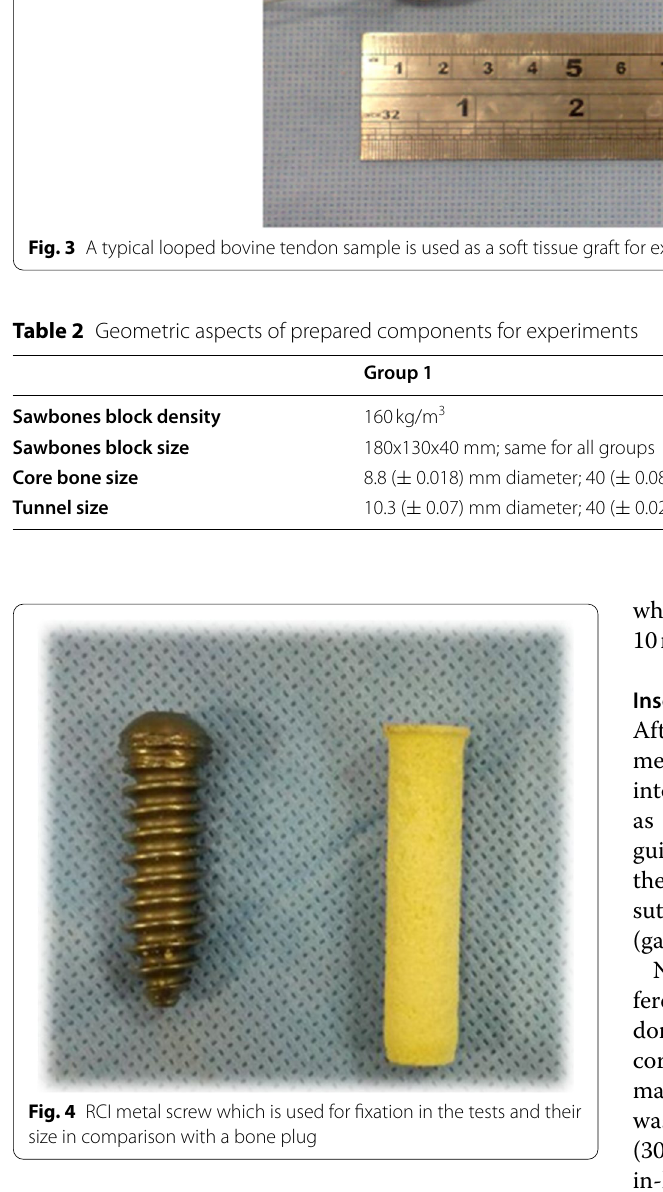
Table 2. Screw preparation The RCI screw from Smith & Nephew Company was used for fixation (Fig. 4). The diameter of the screw was 8 mm, and the overall length of it was 35.2 mm, 30 mm of